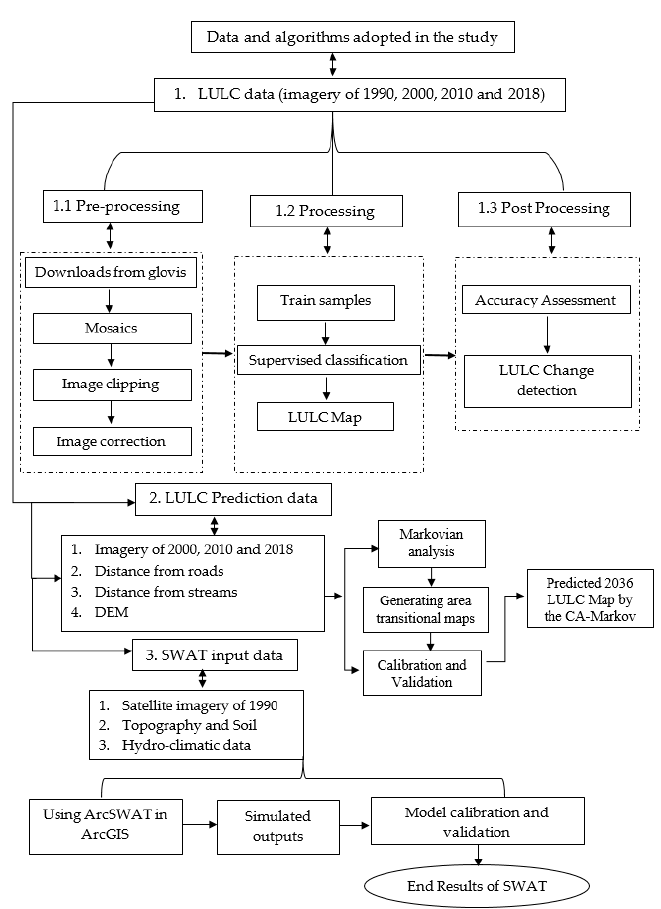
Figure 4. A flowchart describing the data processing.